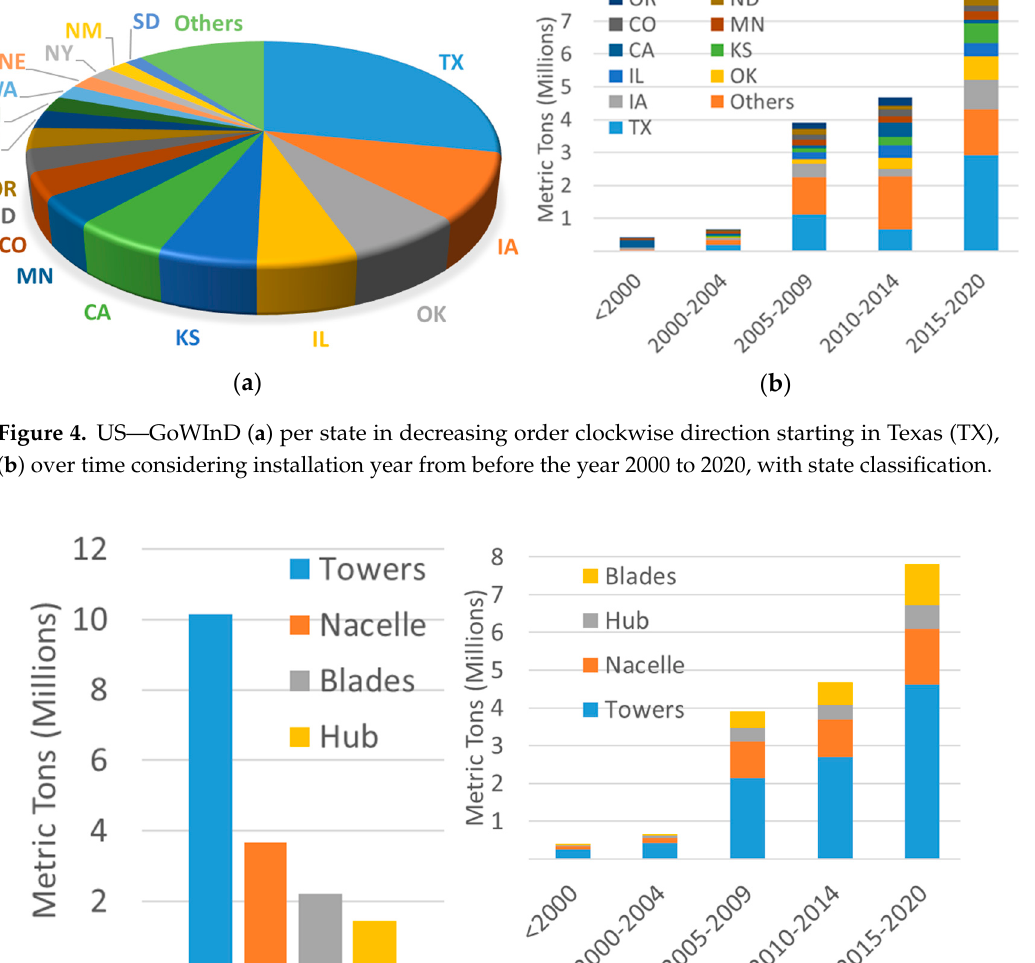
Figure 4. US—GoWInD ( a ) per state in decreasing order clockwise direction starting in Texas (TX), ( b ) over time considering installation year from before the year 2000 to 2020, with state classification.